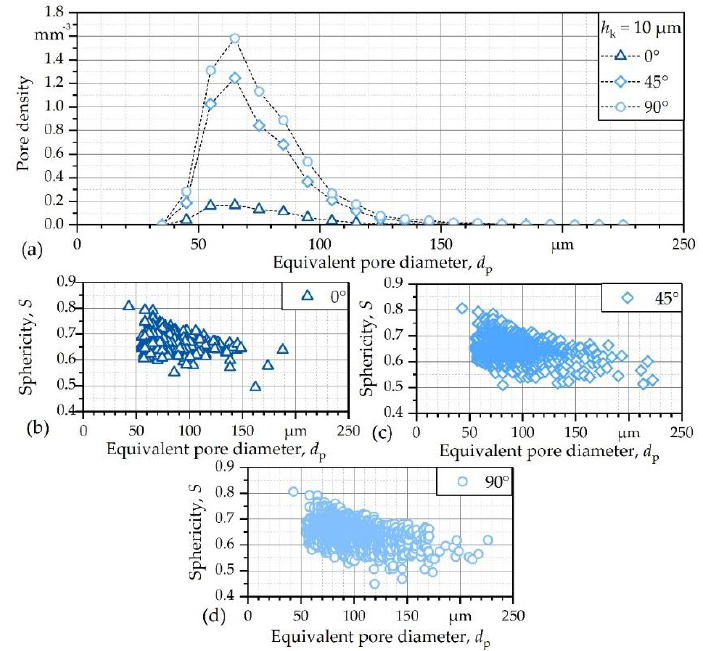
Figure 5. Comparison of defect status of the different orientations: ( a ) pore density; sphericity of ( b ) 0 ◦ specimen; ( c ) 45 ◦ specimen; and ( d ) 90 ◦ specimen.